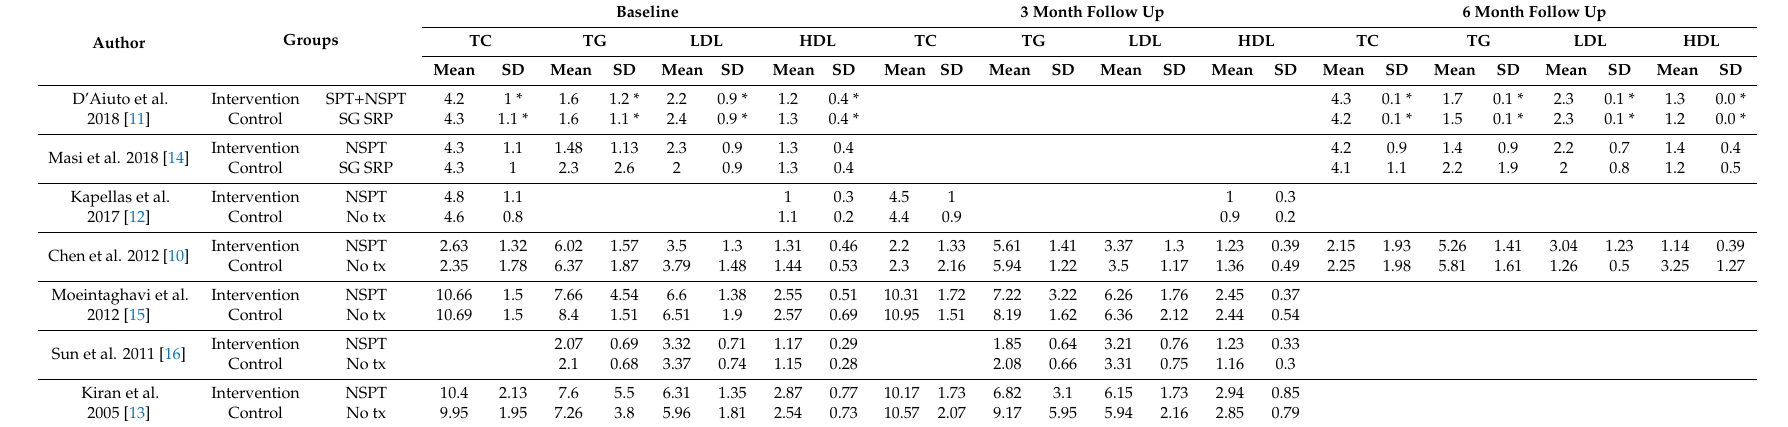
Table 2. Lipid profiles at baseline, 3 months, and 6 months in mmol /